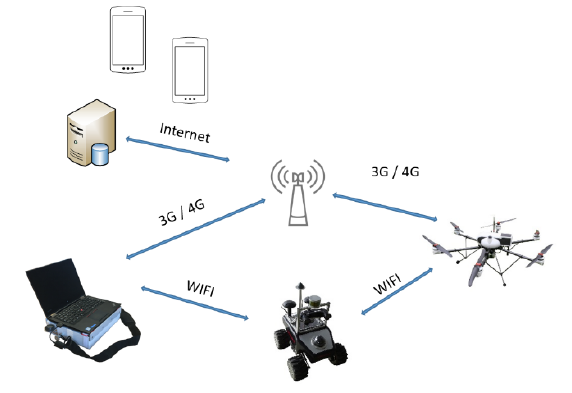
Figure 7: Flexible communication structure between arbitrary agents using decentral ad-hoc networking and internet